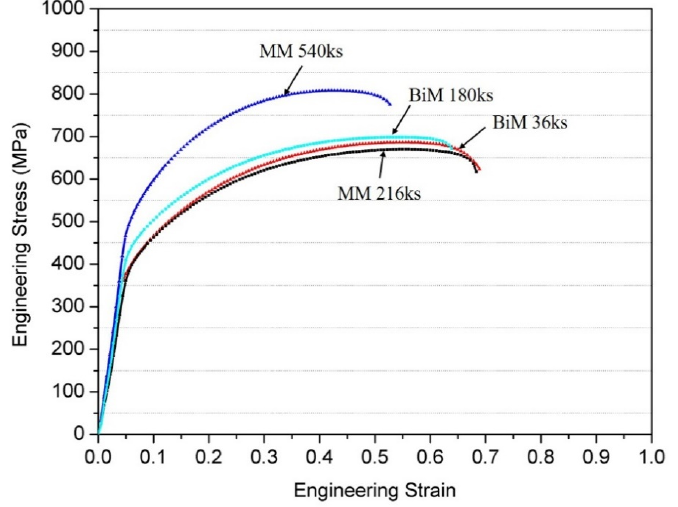
Figure 7. Tensile engineering stress-strain curves of harmonic structured SUS316L compacts developed through BiM and MM processes.